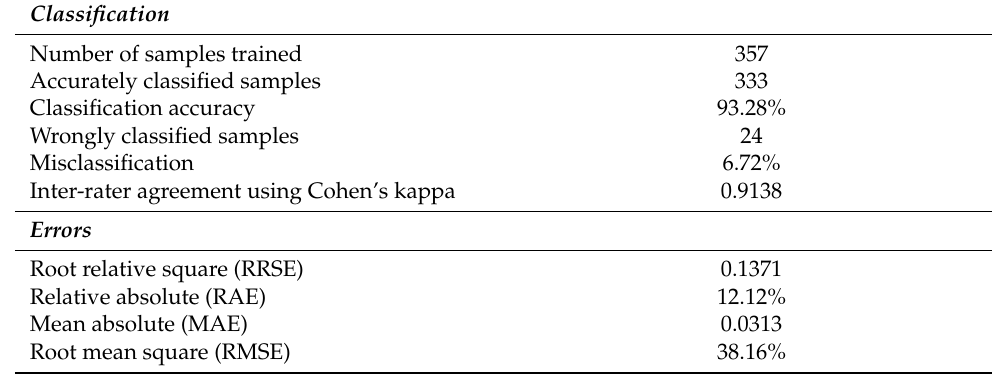
Table 5. Classification result for naïve Bayes.